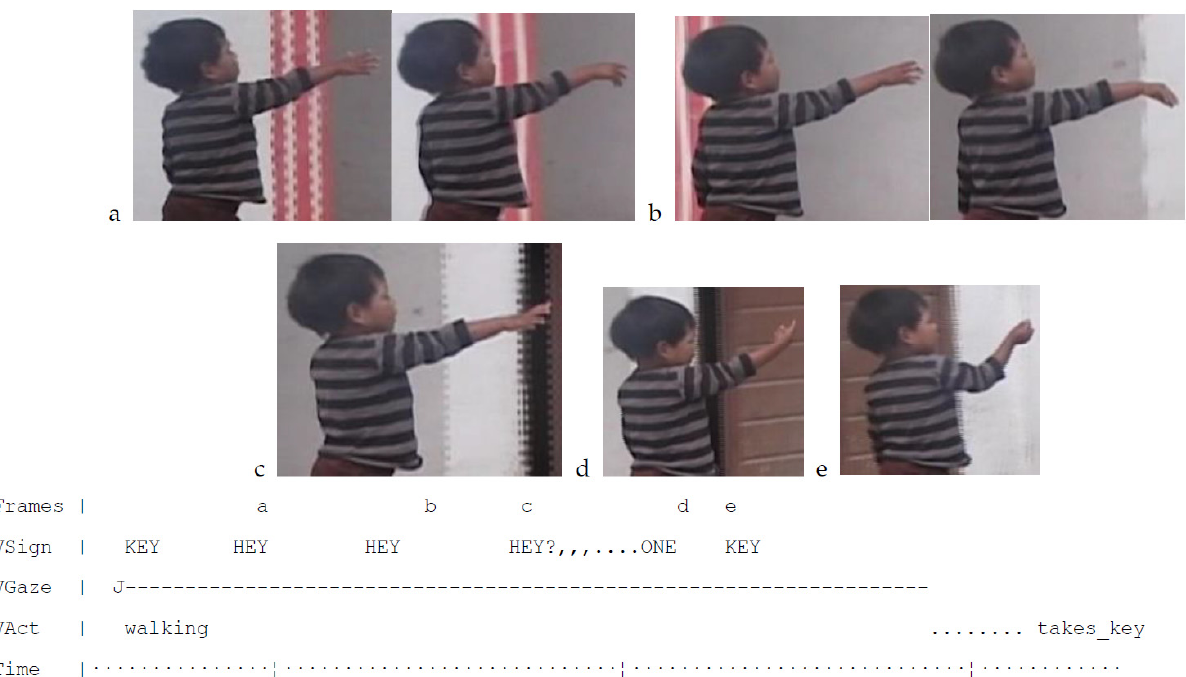
Figure 24. Vic at 27 mos. walked to his mother requesting a key. Vic started toward his mother signing KEY with an outstretched hand. ( a , b ) He then made two HEY signs 300ms. apart and then apparently ( c ) started to make a third HEY. Before completing the downward flip of his hand, ( d ) he formed the sign ONE—often used as a determiner-like element in Z—followed again ( e ) by the sign KEY. He finally took a proffered key from Jane.